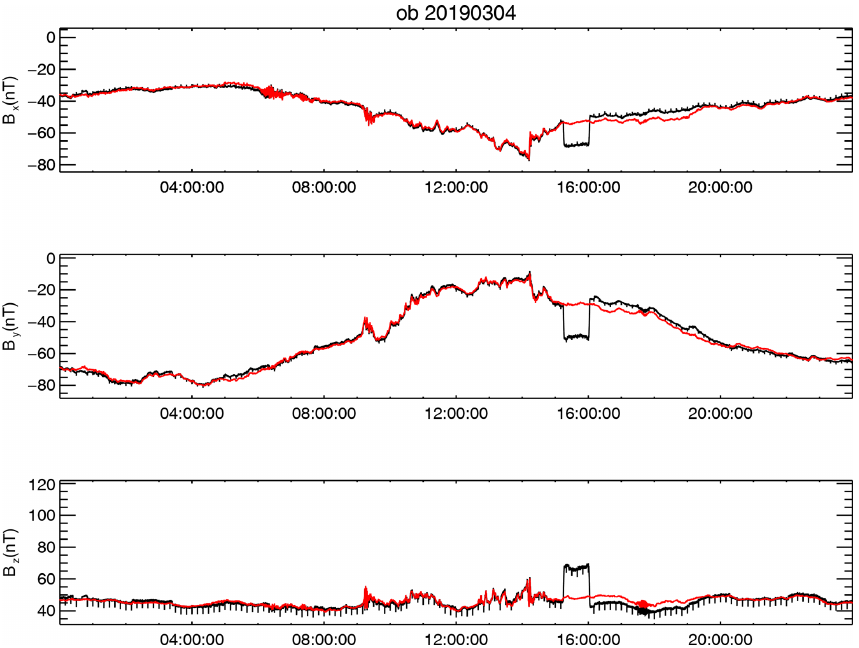
Figure 7. The final combined correction result for 4 March 2019 in the sensor system. The black lines show the original measurements taken by the outboard FGM; the red lines show the corrected data. The DC offset was restored to the value before the